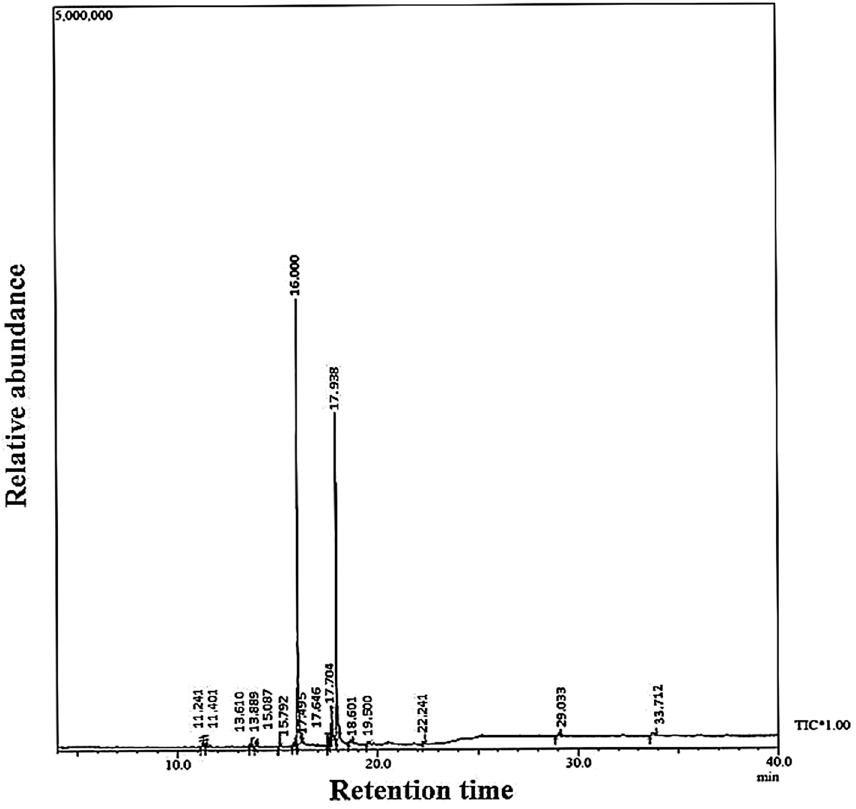
Figure 3. GC–MS profile of Anabaena variabilis cell extract.